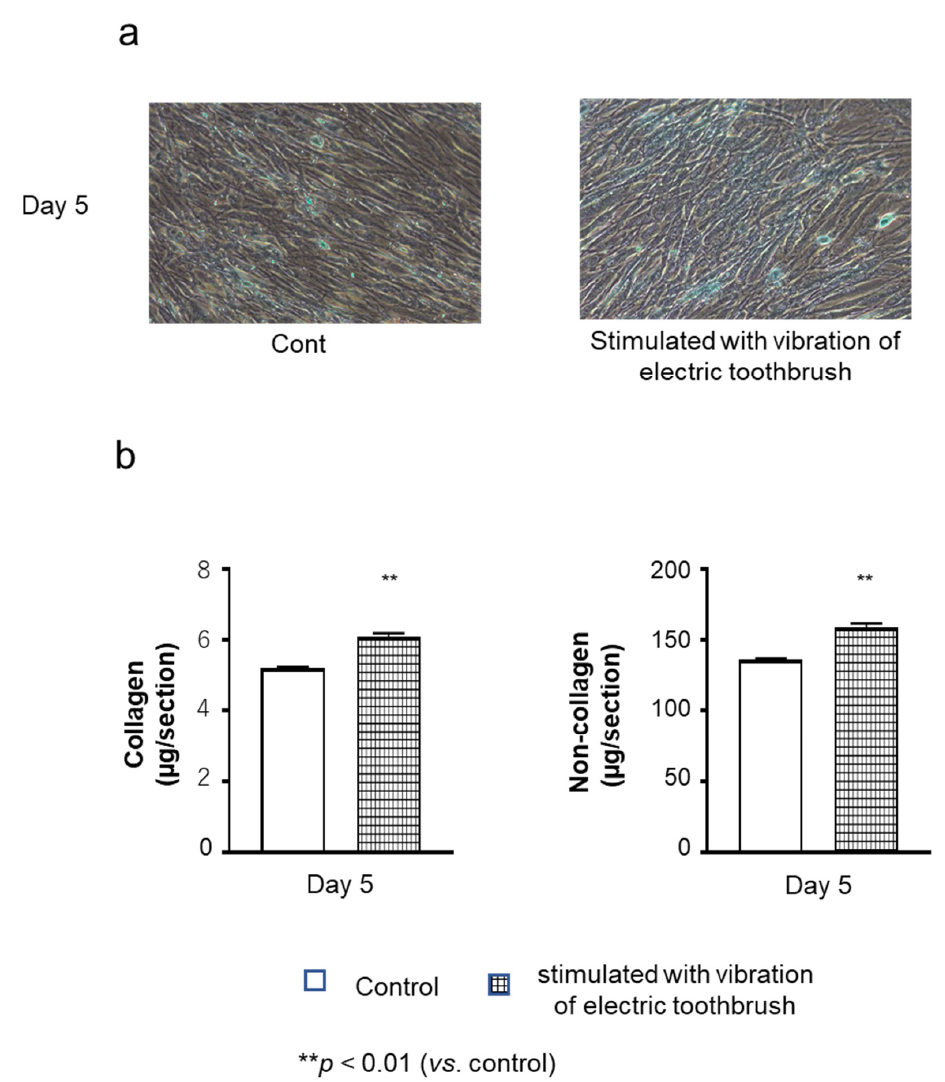
Figure 1. Effects of exposure to vibratory stimulation with an electric toothbrush on the amount of collagenous and non-collagenous proteins in cultured cell layers. HGnFs were exposed to vibratory stimulation with an electric toothbrush for 5 days. Collagenous (red) and non-collagenous (green) proteins were examined by Sirius red and Fast green staining on day 5 of culture ( a ), and quantitative analysis ( b ) was conducted using the stain extraction buffer. Each bar indicates mean ± standard deviation (SD) of five independent experiments. ** p < 0.01 (vs. control).